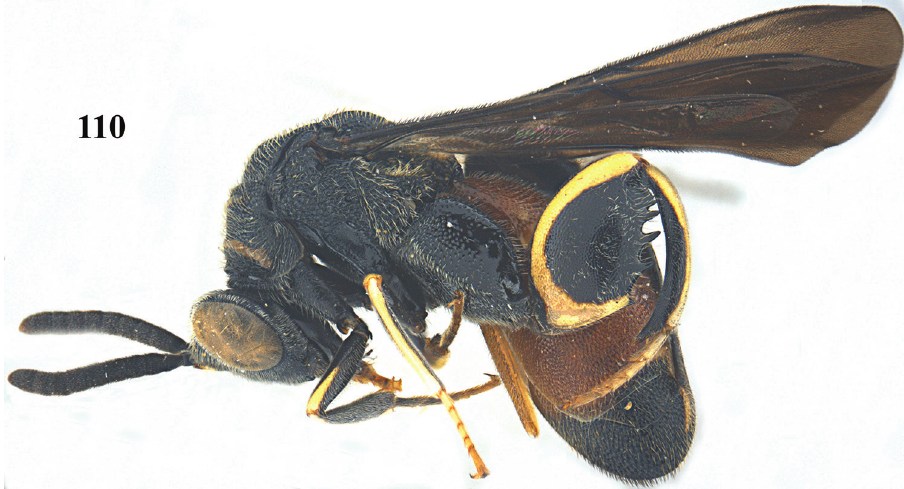
Figure 110. Leucospis petiolata Fabricius, ♀ from Guangdong, Nanling, habitus lateral.